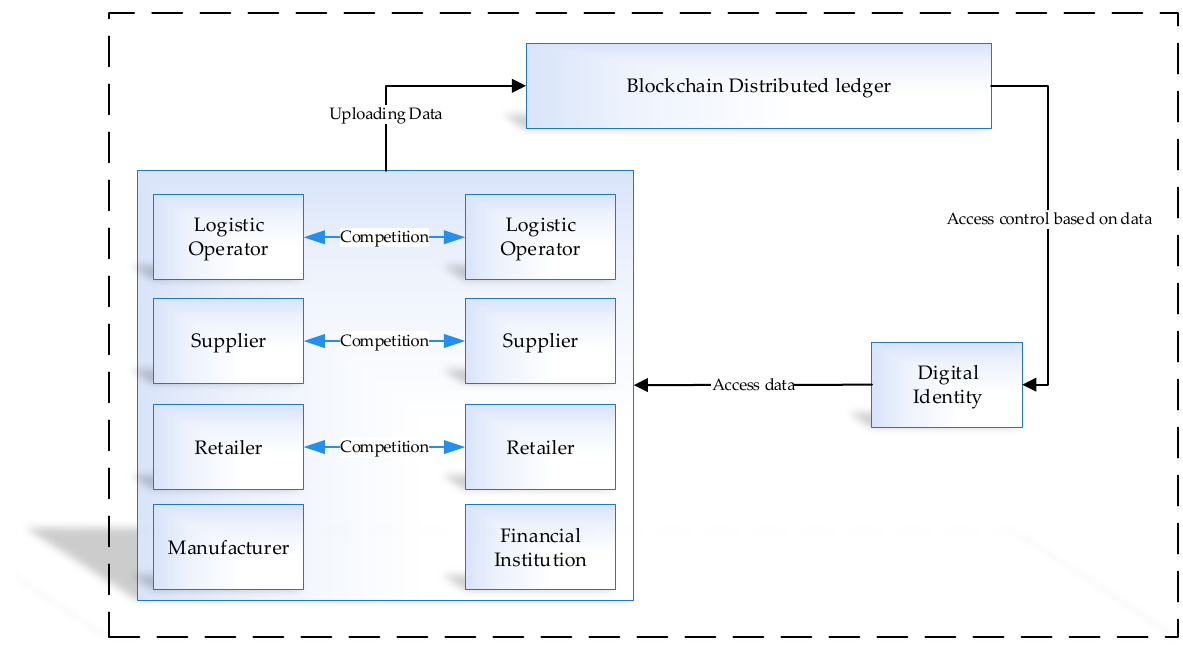
Figure 4. Distributed ledger digital identity based on